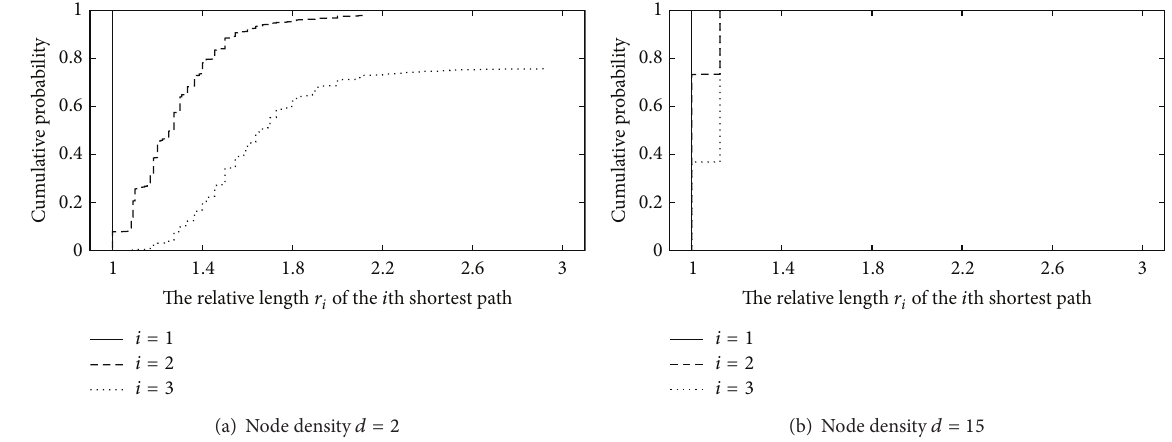
Figure 2: Influence of node density 𝑑 on characteristics of the three shortest node-disjoint